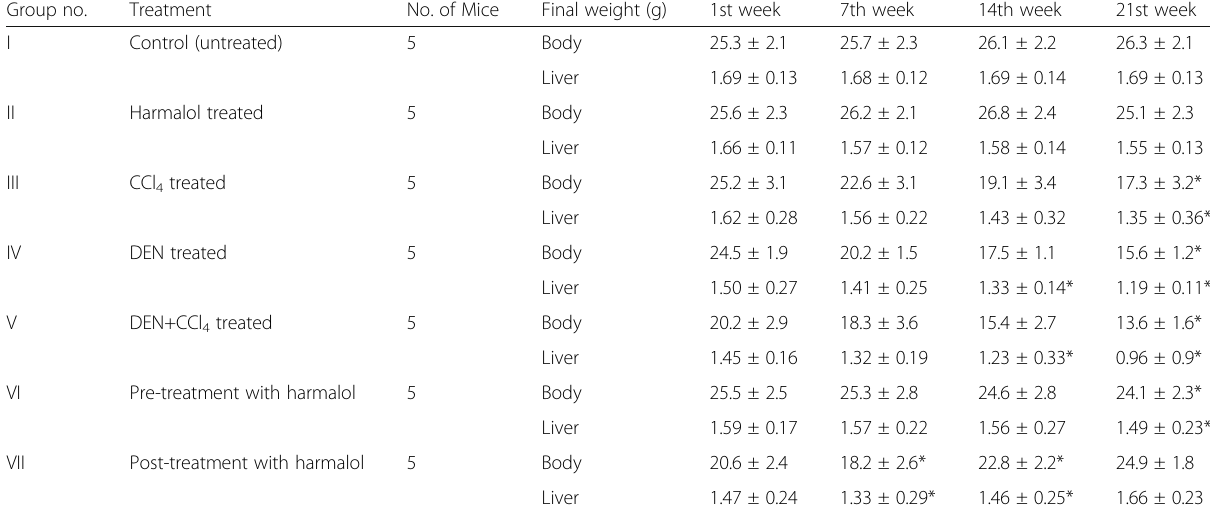
Table 2 Body and liver weight in Swiss albino mice Group